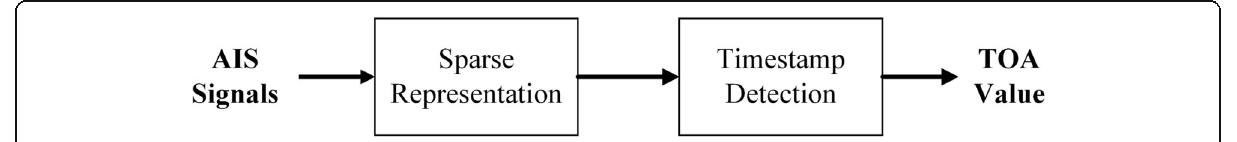
Fig. 1 System block diagram: the simple system block diagram of holographic detection of AIS real-time